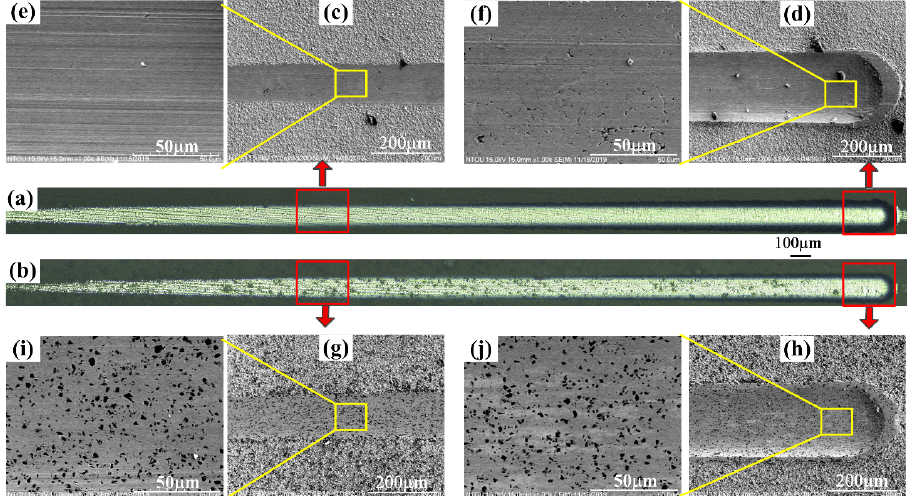
Figure 7. The scratch tracks of the Ni–diamond coating and the Ni coating. ( a , b ) are scratch tracks of the Ni coating and the Ni–diamond coating, respectively. ( c , d ) are scratch tracks of Ni coating at the one-third position and end position, respectively. ( e , f ) are magnified scratch tracks of ( c , d ). ( g , h ) are scratch tracks of the Ni–diamond coating at the one-third position and end position, respectively. ( i , j ) are magnified scratch tracks of ( g , h ), respectively.